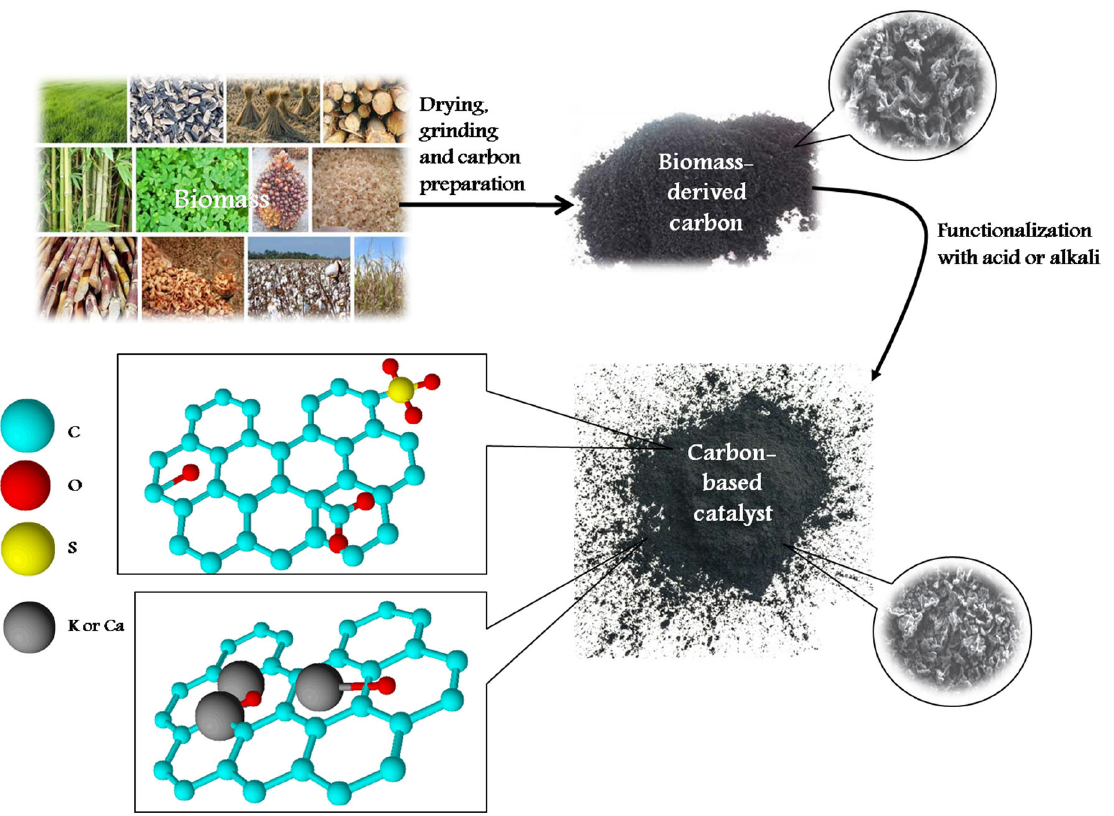
Figure 2. Biomass ‐ derived carbons for the application in biodiesel production. Summarized from Figure 2. Biomass-derived carbons for the application in biodiesel production. Summarized [23–46]. from